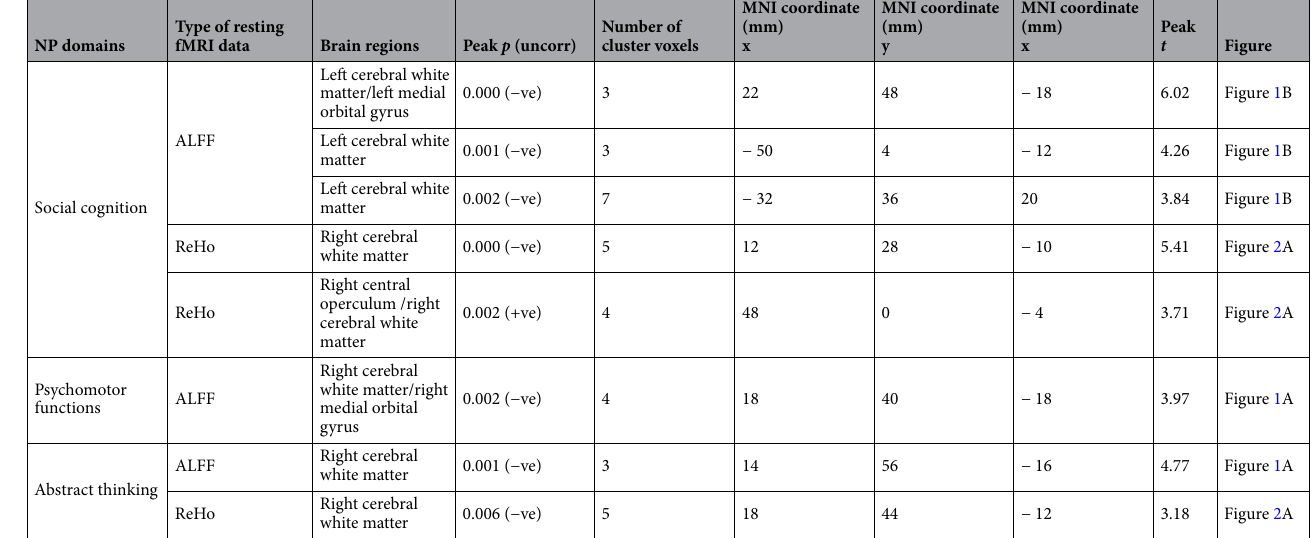
Table 4. Correlation of resting fMRI data with neurocognitive variables. Brain regions masked with significantly higher regional neuronal activity in the pediatric HIV group compared to healthy controls, showed mostly negative correlation (peak uncorrected p < 0.01, cluster size ≥ 3) of Social Cognition, negative correlation of Psychomotor Functioning and negative correlation of Abstract Thinking with regional neuronal activity in the 11 pediatric HIV patients. + ve indicate positive correlation and − ve indicate negative